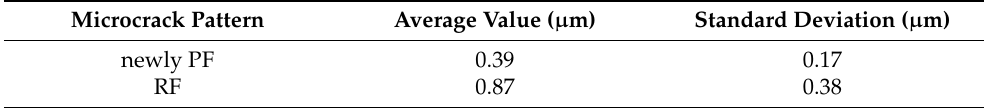
Table 3. Average value and standard deviation of microcrack branching.